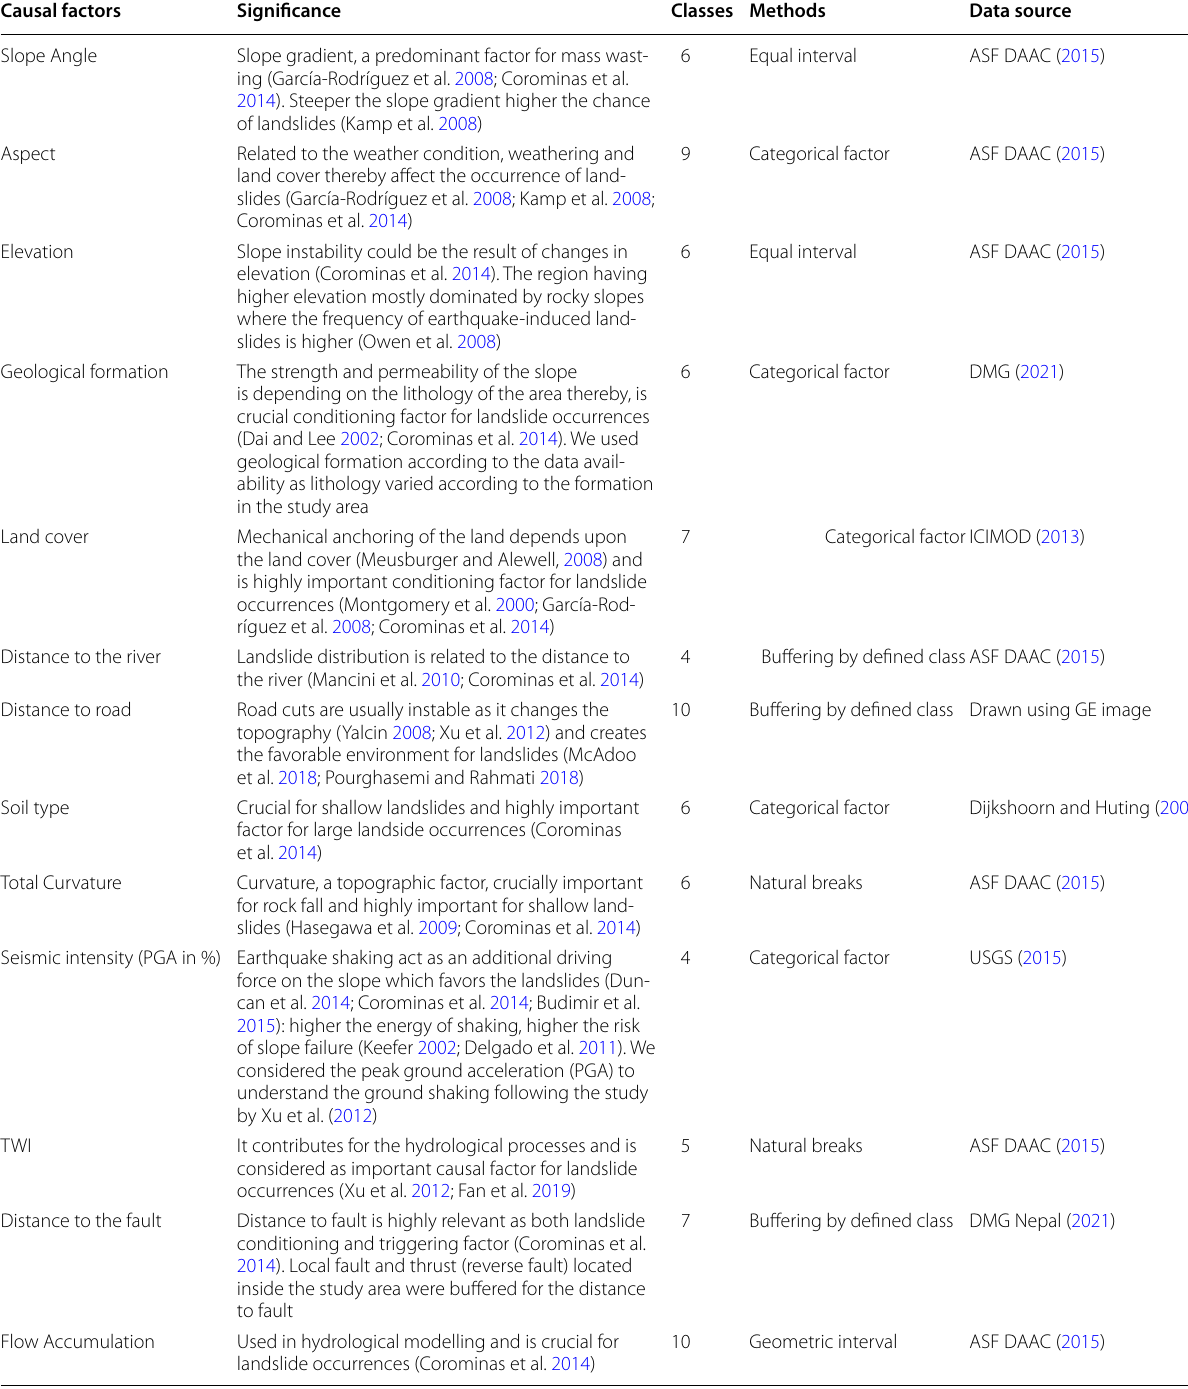
Table 1 Causal factors and their significance for landslide occurrence with the references Causal